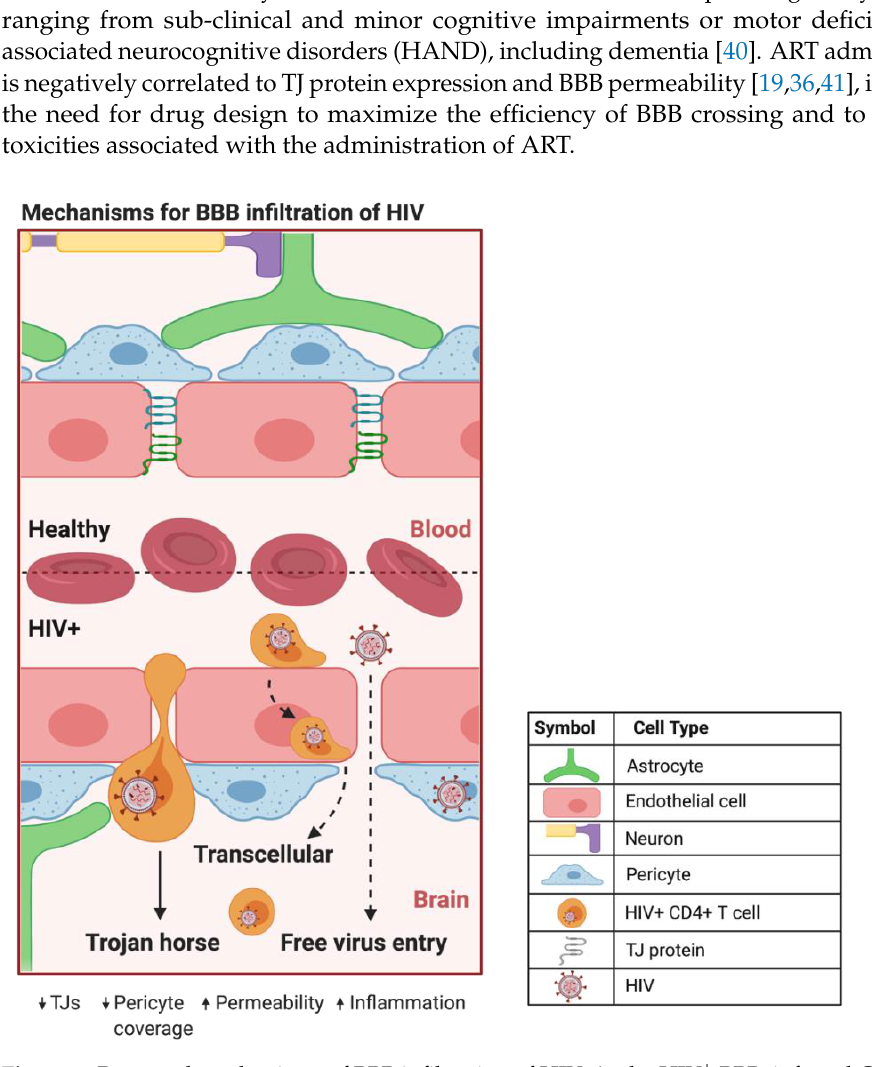
Figure 2. Proposed mechanisms of BBB infiltration of HIV. At the HIV + BBB, infected CD4 + T cells and monocytes can cross by several proposed mechanisms. The predominate method centers around HIV using infected CD4 + T cells and monocytes as a Trojan horse to paracellularly infiltrate brain parenchyma. HIV + monocytes can also transcellularly pass through CMECs at the BBB. As HIV infection progresses in the CNS, increased BBB permeability and decreased expression of TJ proteins can provide a pathway for HIV to paracellularly invade the brain parenchyma. Created with BioRender.com. Abbreviations: HIV + = human immunodeficiency virus-infected; TJs = tight junctions.